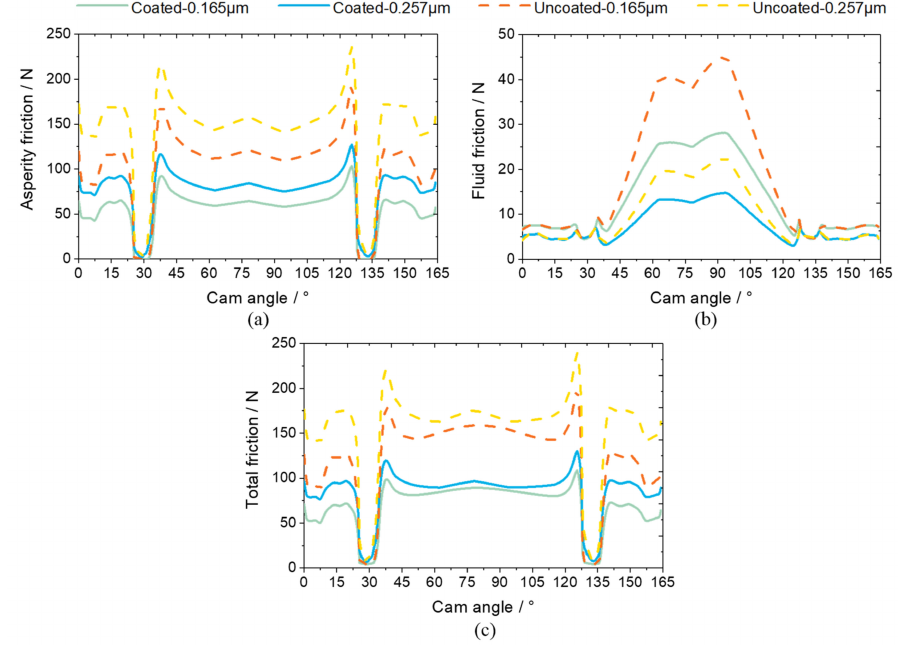
Figure 8. Frictional variations during a cam cycle under the normal load: ( a ) asperity contact friction, ( b ) fluid friction, and ( c ) total